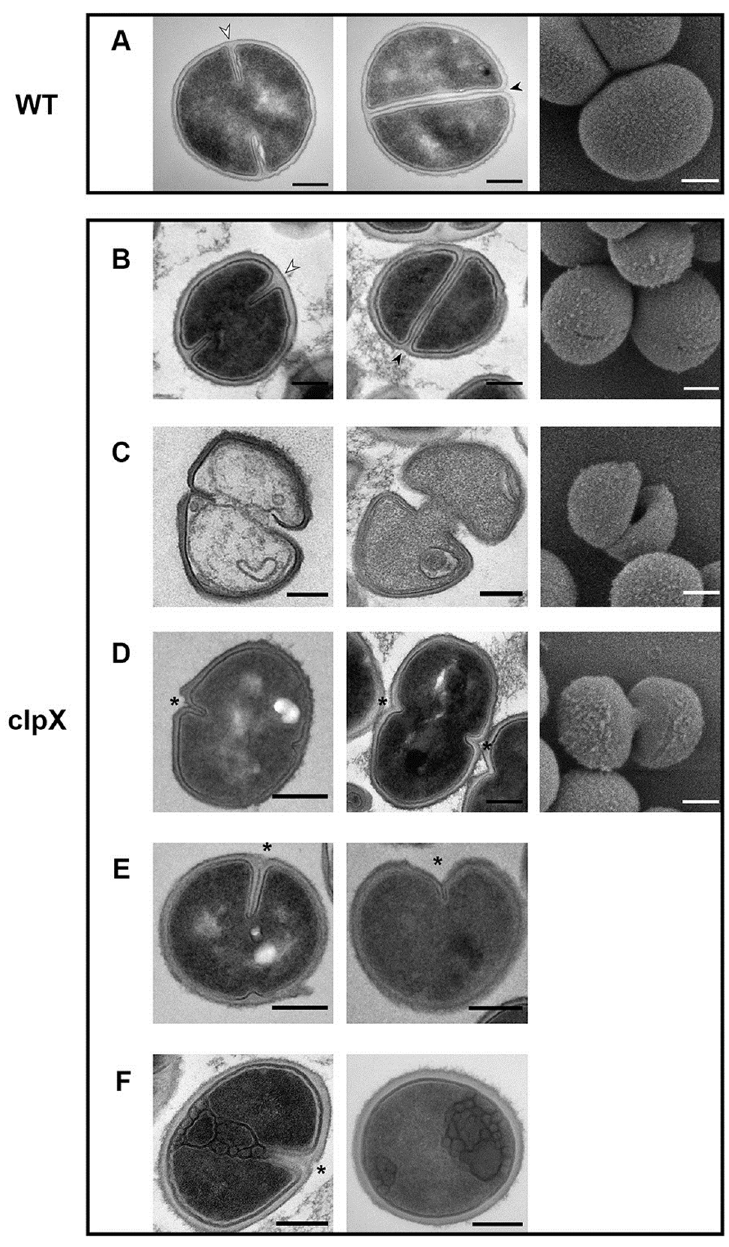
Fig 3. S . aureus clpX cells grown at 30˚C display aberrant septum ingrowth and initiate daughter cell separation prior to septum closure. TEM (left panels) and SEM (right panel) images of SA564 wild-type ( A ) or clpX cells ( B-F ) grown in TSB to mid-exponential phase at 30˚C. Images show characteristic morphologies of SA564 wild-type or clpX cells at 30˚C as determined from at least three biological replicates. clpX cells displaying the normal coccoid morphology ( B ); the typical appearance of lysed clpX cells ( C ); clpX cells with non-divided cytoplasma displaying premature splitting of daughter cells ( D ); clpX cells displaying asymmetrical septum ingrowth, ( E ); clpX cells displaying mesosome-like structrues at the septal site ( F ). White arrows point to the intact peripheral cell wall at the site of septum that is typical for wild-type cells with unclosed septa, while black arrows point to signs of daughter cell splitting initiating from the peripheral wall in cells with closed division septa. Asterisk mark clpX cells that despite displaying an incomplete septum show signs of daughter cell splitting initiating from the peripheral wall. The displayed morphological changes are typical for clpX cells also in other S . aureus strain backgrounds tested (8325–4, and JE2). Scale bar, 0.2 μ m.